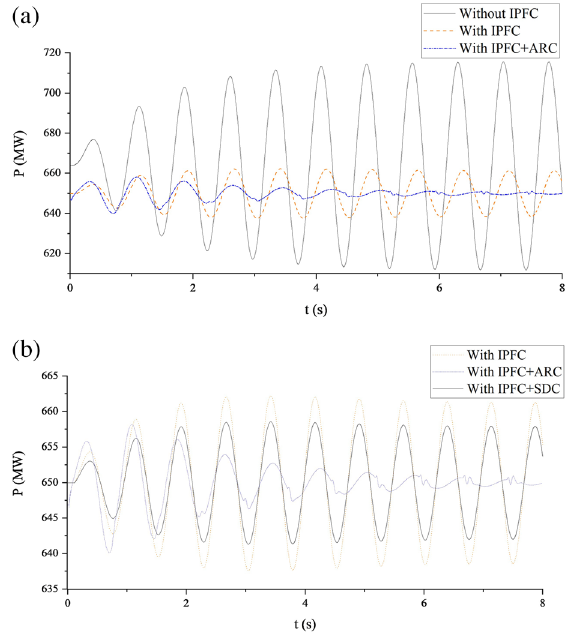
Fig. 9 Simulation results of P ik of forced oscillation in the main control transmission line: a For cases: without IPFC, with IPFC only, and IPFC based on ARC; b For cases: with IPFC only, IPFC based on ARC, and IPFC based on ARC